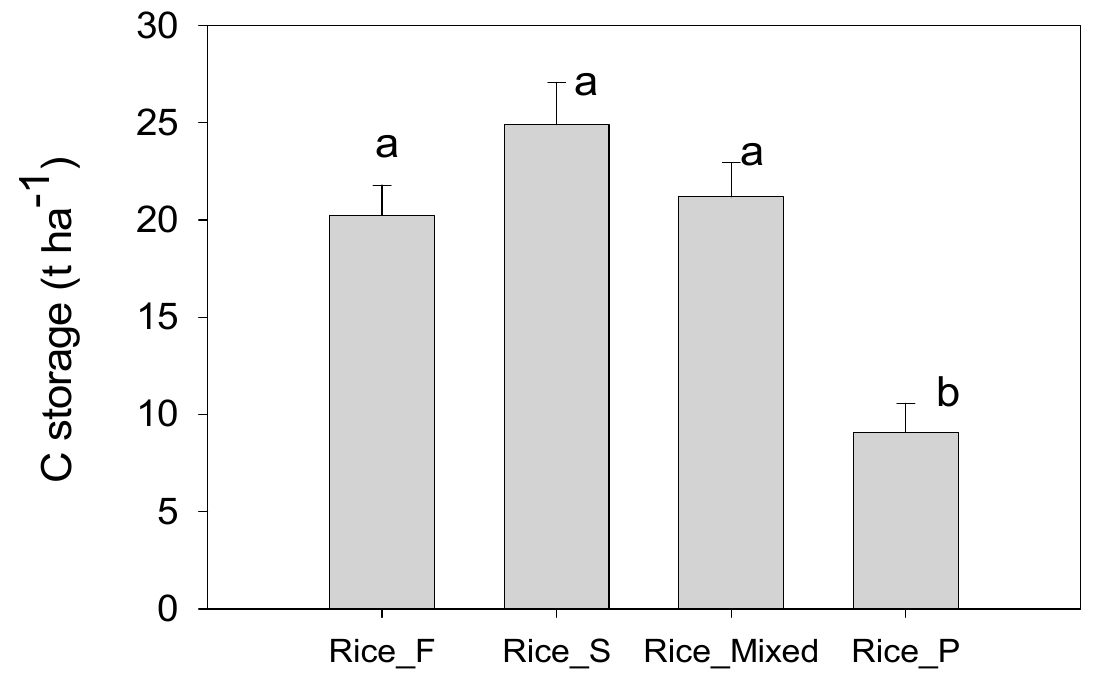
Figure 7. Carbon storage under an individual RRCS at a depth of 0–30 cm. Note: The difference in lowercase letters means that the treatments differ significantly ( p < 0.05) with the standard error above the bar.